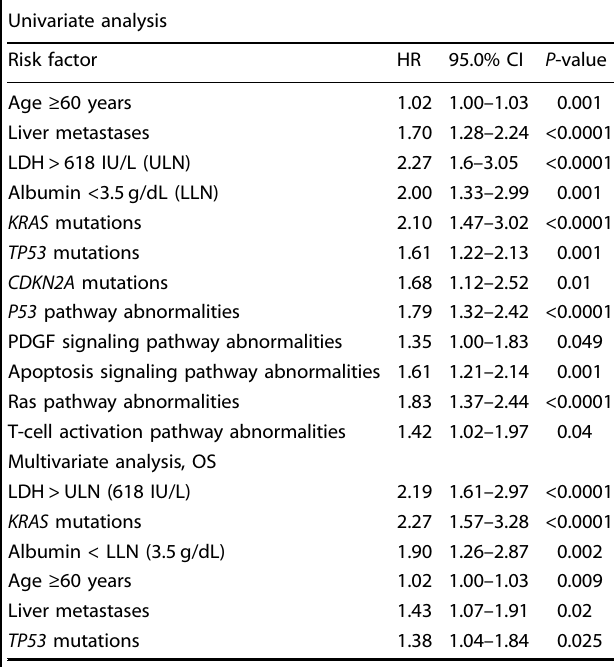
Table 2. Univariate and multivariate analysis for overall